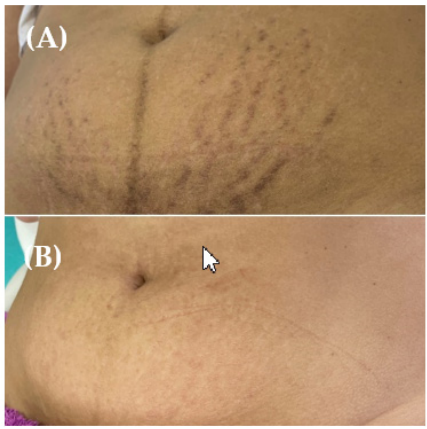
Figure 4. Before ( A ) and after ( B ) control photos of abdominal striae of an individual subjected to laser CO 2 treatment.